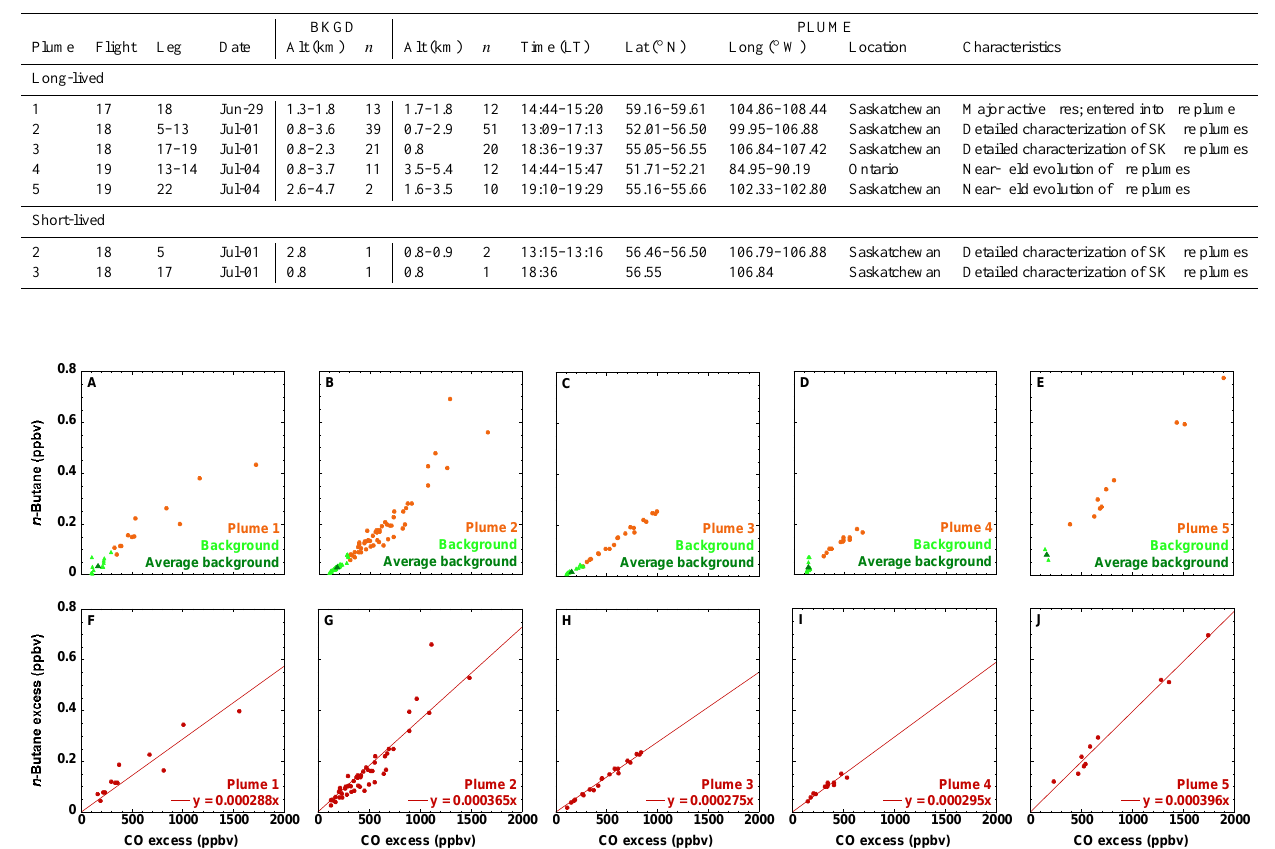
Table 2. Characteristics of five biomass burning plumes that were used to analyze the long-lived NMVOCs ( > 1.4 d). A small subset of Plumes 2 and 3 were used for the analysis of short-lived NMVOCs ( ≤ 1.4 d). All times are local (UTC – 07:00 h). n = number of samples; SK = Saskatchewan.